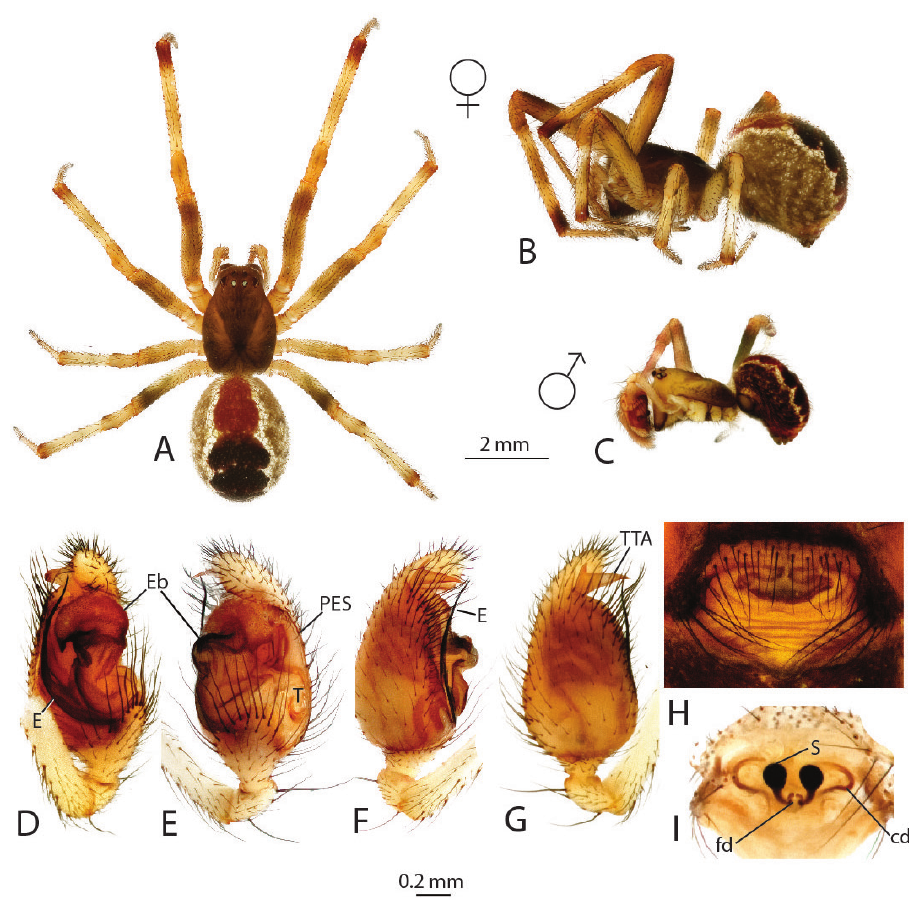
Figure 2. Anelosimus may : A–B female dorsal and lateral views C male lateral view D–G male palp ventral, subectal, mesal, dorsal H epigynum ventral I epigynum dorsal. tane forest, 1500 m alt, col. J. J. Rafanomezantsoa et al., in CAS, examined (see